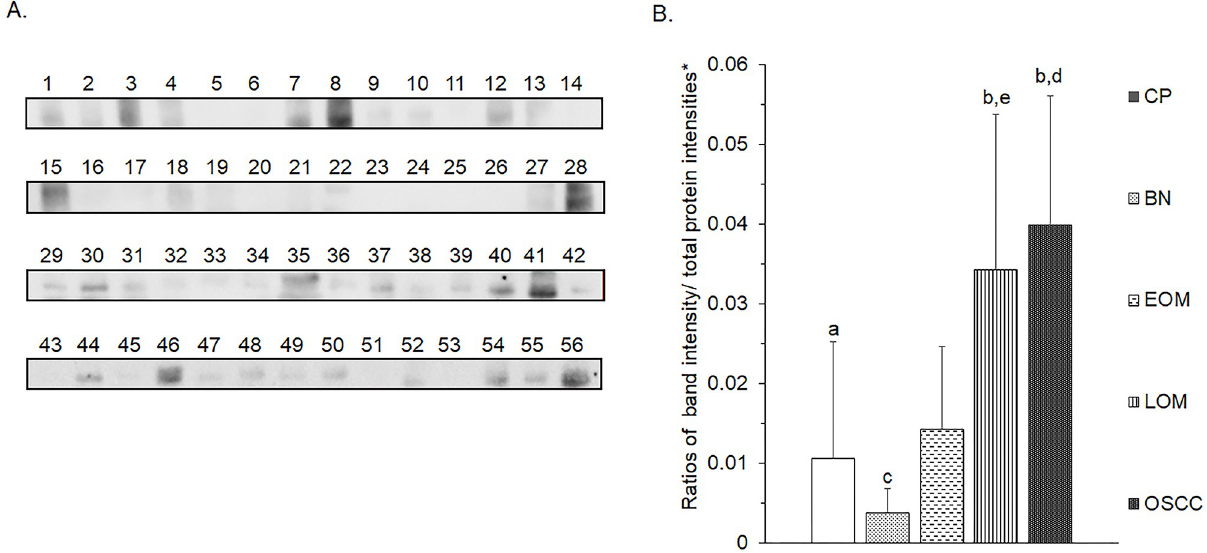
Fig 13. Western blot analysis of salivary toll like receptor 4 (TLR4) of individual saliva samples from dogs with benign oral tumors (BN), early- and late-stage oral melanoma (EOM and LOM, respectively), oral squamous cell carcinoma (OSCC) and periodontitis and normal controls (CP). Representative western blot for TLR4 at 95 kDa (A) and bar graph of ratios of TLR4 protein intensity to total blotted proteins in each lane in the first half of a membrane � (B) . a–b, c-d and c-e denote a significant difference at p < 0.05, p < 0.01 and p < 0.001,